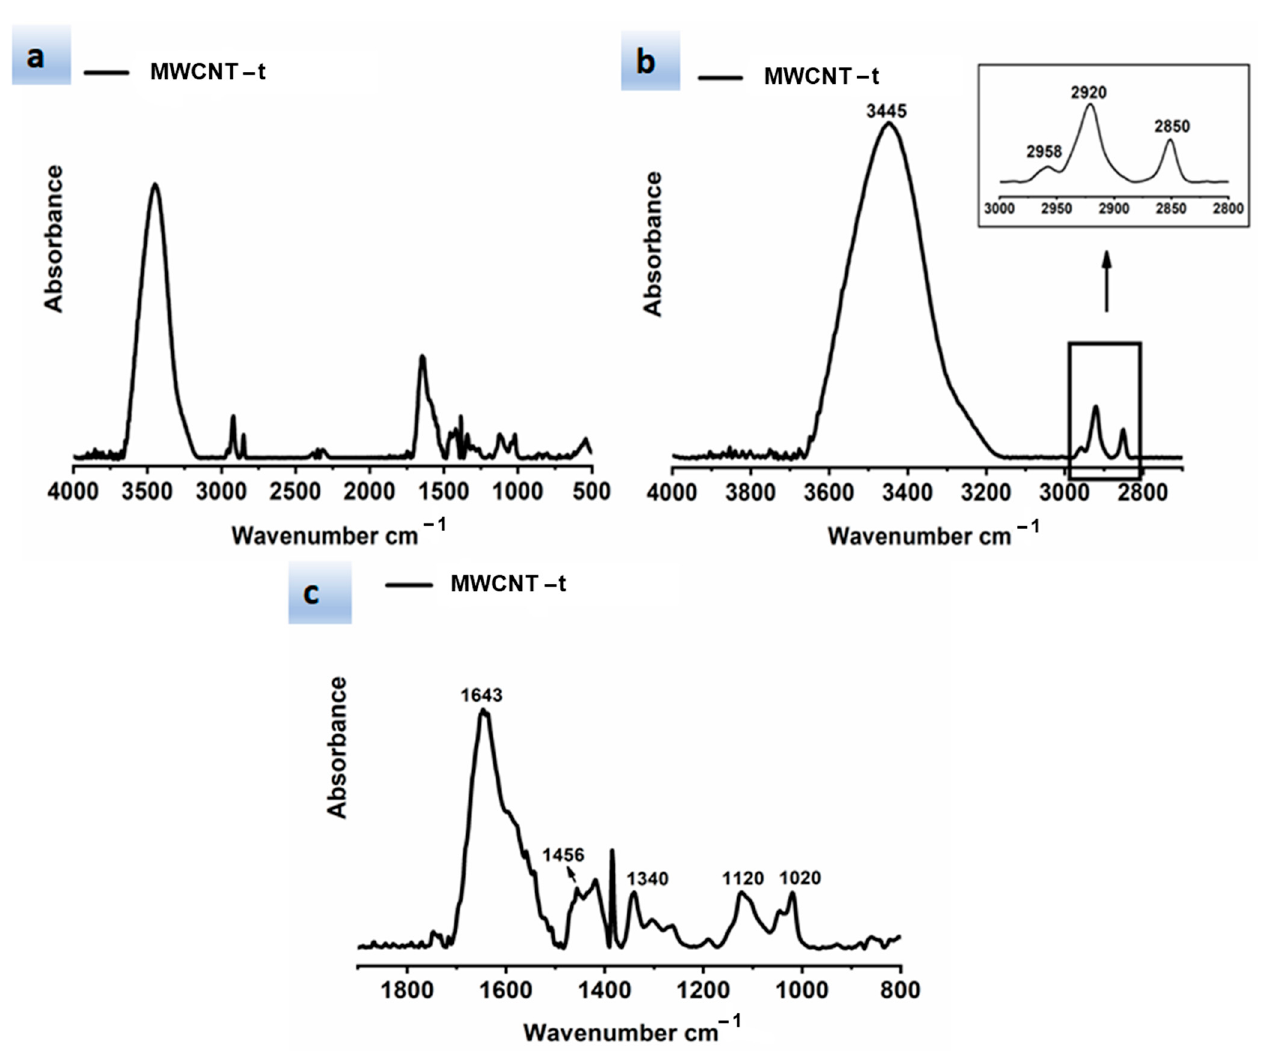
Figure 6. FTIR spectrum of MWCNT–t shown at different spectral ranges of wavelengths: ( a ) spectral range 4000–500 cm − 1 ; ( b ) spectral range 4000–2700 cm − 1 with inset at higher magnification; ( c ) spectral range 1900–800 cm − 1.